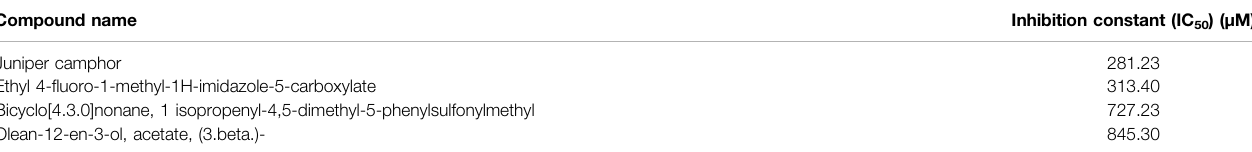
TABLE 6 | Inhibition constant (IC 50 ) of major bioactive compounds from methanol extract of C.